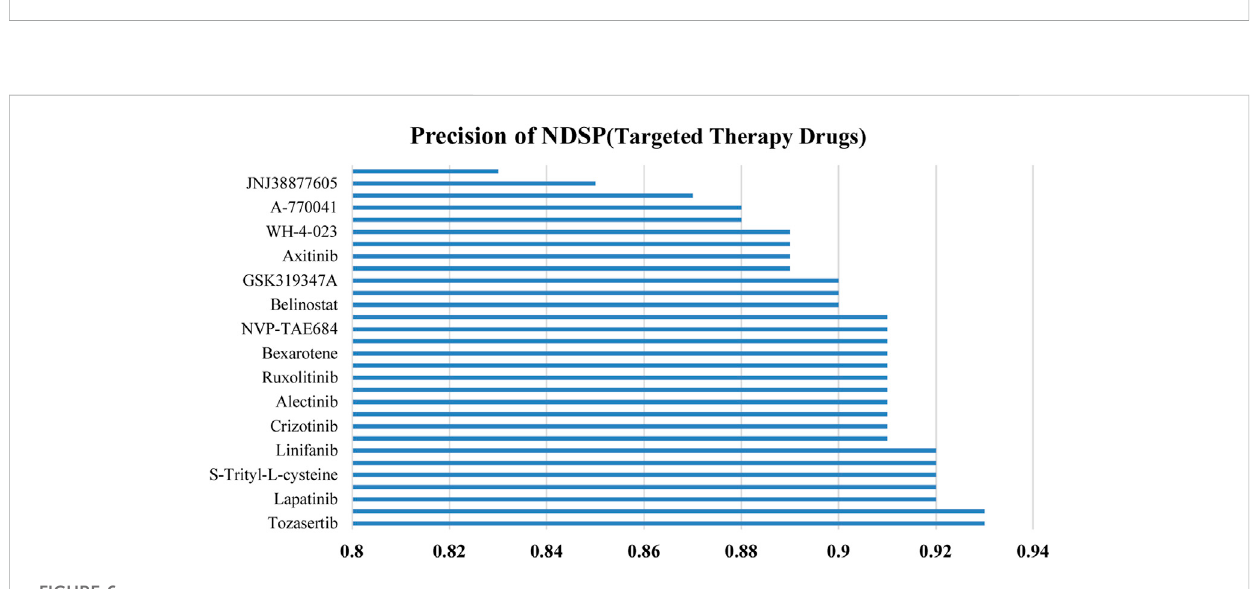
FIGURE 5 Accuracy of all 8 models on 30 targeted therapy drugs (the points outside the boxplot are outliers).